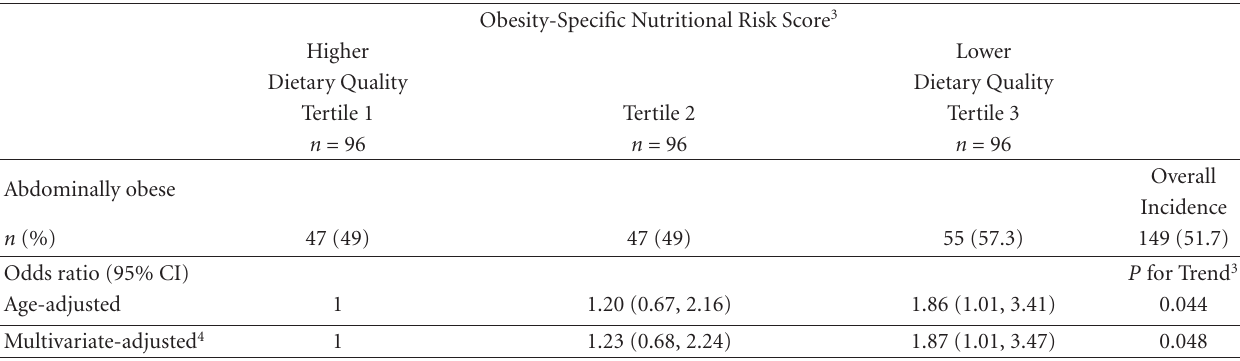
Table 3: Development of abdominal obesity over 12 years in 288 healthy women in the Framingham O ff spring-Spouse Study according to dietary quality 1